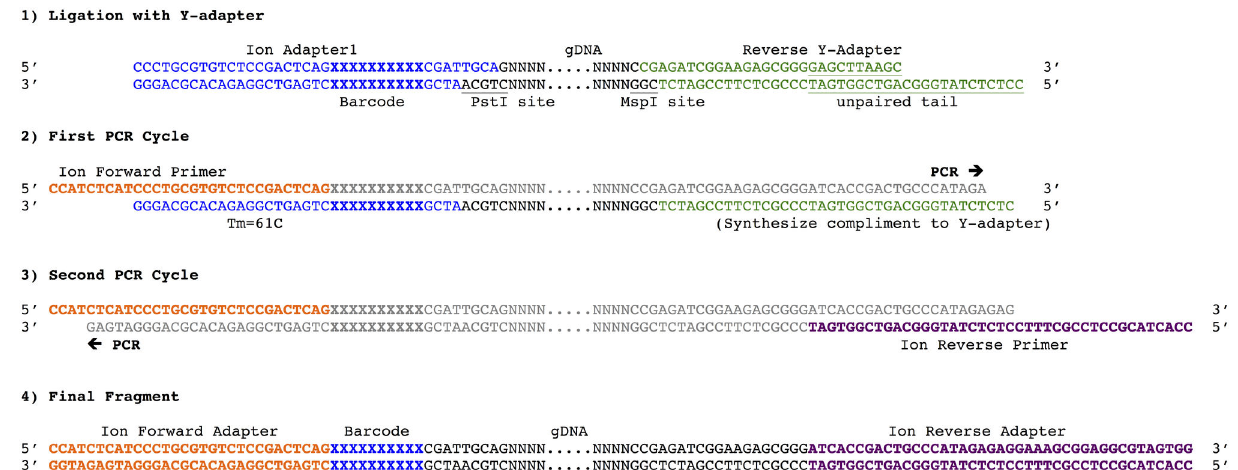
Figure 1. Design of genotyping-by-sequencing adapters for use with Ion Torrent sequencing chemistry. 1) Genomic DNA (black) is digested with a combination of Pst I and Msp I producing fragments with corresponding 3’ TGCA ( Pst I) and 5’ CG ( Msp I) overhangs. The barcoded forward Ion Adapter 1 (blue) is ligated to the Pst I generated overhang and the common Ion Adapter 2 (green) is ligated to the Msp I generated overhang. The variable bar code is in bold and the unpaired tail of the Y-adapter is underlined. 2) During the first PCR cycle, the forward primer (orange) binds to the corresponding Adapter 1 site and proceeds to synthesize the complementary strand (grey) to the genomic sequence tag and then the unpaired tail of the Y-adapter. The common Msp I- Msp I fragments (not shown) have a Y-adapter on both ends and lack a complementary binding site to initialize PCR amplification. 3) During the second and subsequent rounds of PCR, the reverse primer (purple) can bind to the newly synthesized complement and initialize synthesis on the reverse strand. These PCR reactions continue until completion of the fully synthesized fragments. 4) The final fragment is ready to sequence and consists of the Ion Torrent forward priming site (orange) with a bar code (blue) followed by the genomic sequence fragment (black) and the Ion Torrent reverse priming site